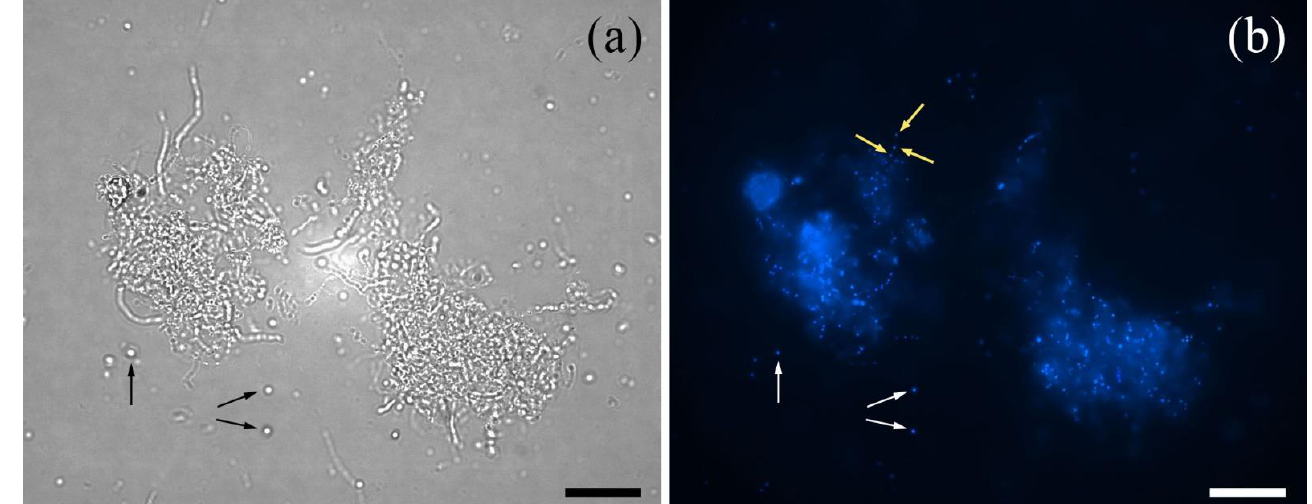
Figure 1. Mycelium clumps and protoplasts (examples of the latter are indicated by black and white arrows in panel ( a ) and ( b ), respectively), observed with optical fluorescence microscope (Zeiss Axioscope) at 400× magnification ( a ). DAPI staining ( b ) evidenced the complexity of the multinucleated mycelium clumps in comparison to protoplasts and the even distribution of nuclei in the hyphae (as indicated by light yellow arrows). Pictures were taken during protoplast formation (12 h of incubation in the lytic solutions). Bar dimension: 10 μ m.